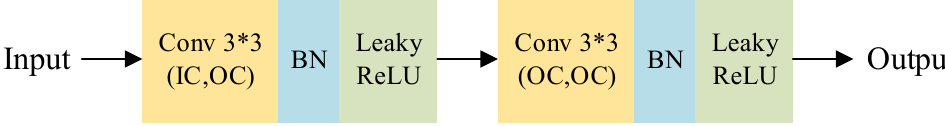
Figure 4. The diagram of the building block in